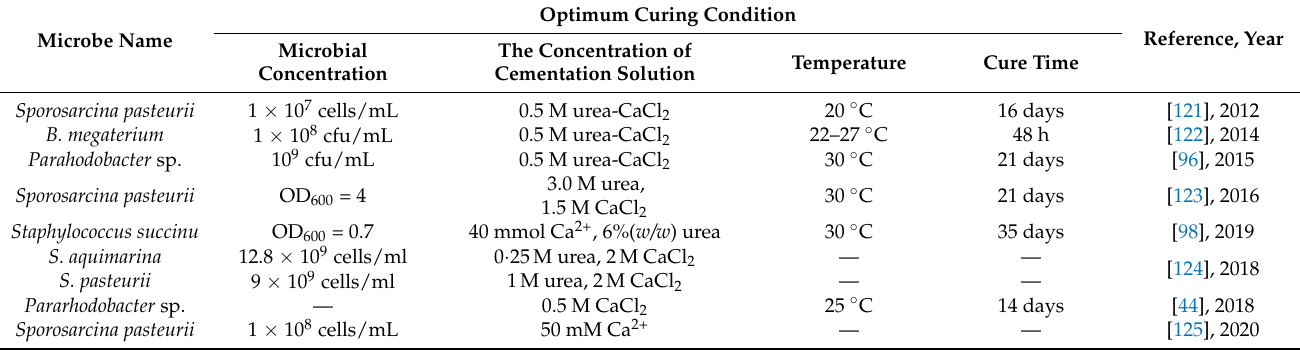
Table 5. Results on the optimal curing conditions of urease-producing